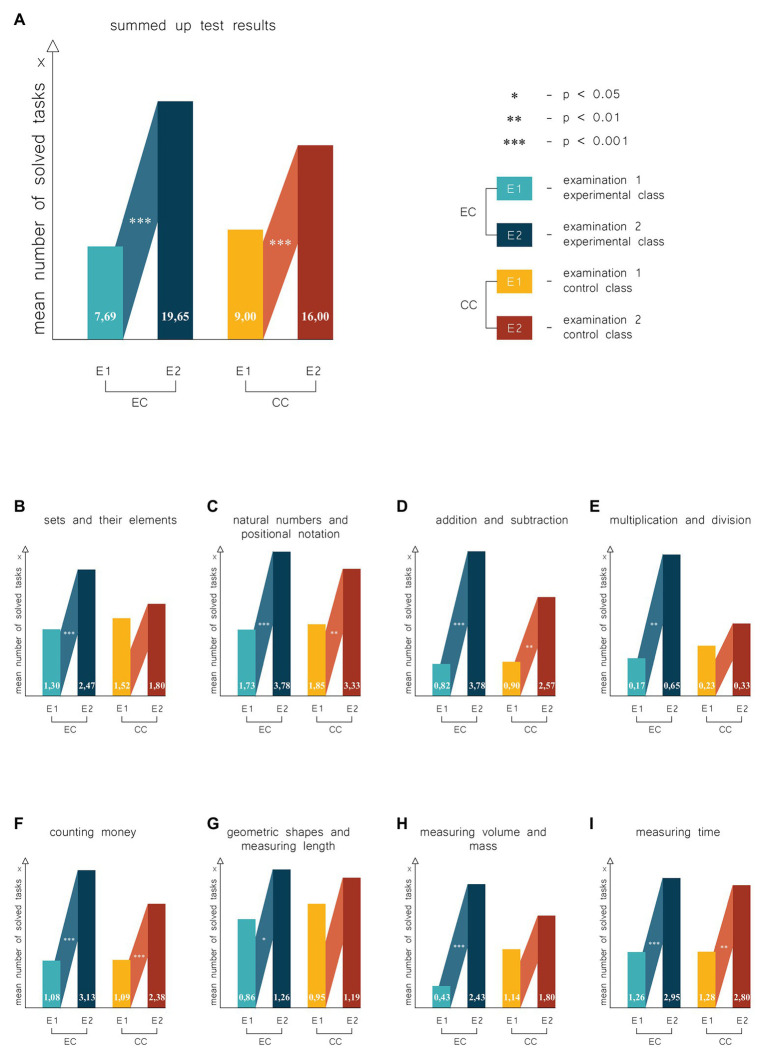
Results of experiment. Statistical analysis of the results in terms of mathematical knowledge and skills included eight categories consistent with the assumptions of the mathematical diagnosis test. (A) Results of experiment for all categories. (B) Results for the category: sets and elements of sets. (C) Results for the category: natural numbers and positional notation. (D) Results for the category: addition and subtraction. (E) Results for the category: multiplication and division. (F) Results for the category: counting money. (G) Results for the category: geometric shapes and measuring length. (H) Results for the category: measuring volume and mass. (I) Results for the category: measuring time. EC, experimental class; CC, control class; Examination 1, the examination at the beginning of the school year (in September); Examination 2, the examination carried out at the end of the school year (in June).